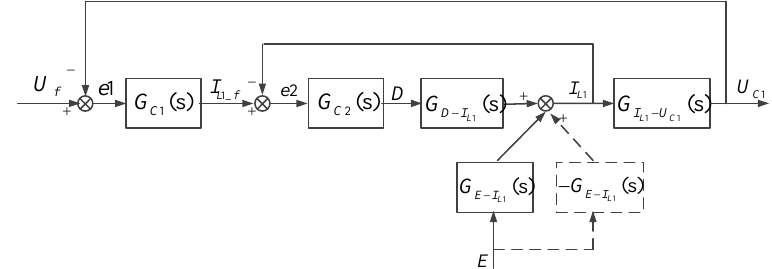
World Electric Vehicle Journal 2020 , 10 , x Figure 9. Control block diagram after adding input voltage disturbance. Figure 9. Control block diagram after adding input voltage disturbance. Figure 9. Control block diagram after adding input voltage disturbance.